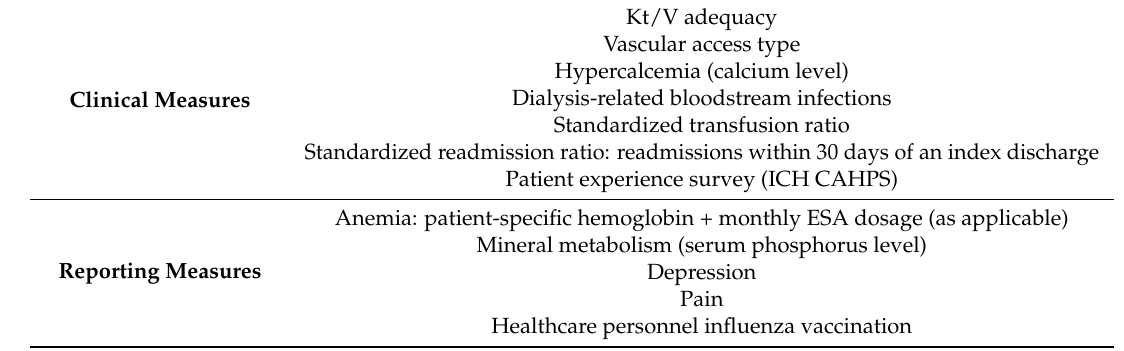
Table 1. QIP measures payment year (PY) 2019 (Calendar year for patient data is 2017).